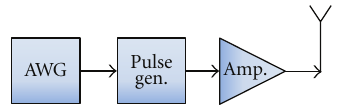
Figure 3: Block diagram of the IR-UWB transmitter